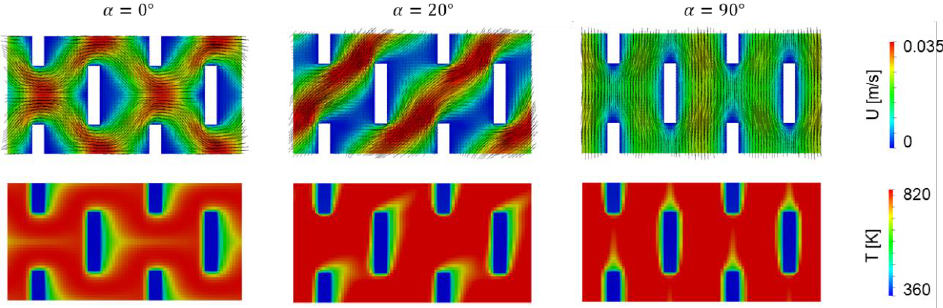
Figure 8. Offset-strip fins turbulator: Detail of the flow field with average velocity U = 0.01 m/s.